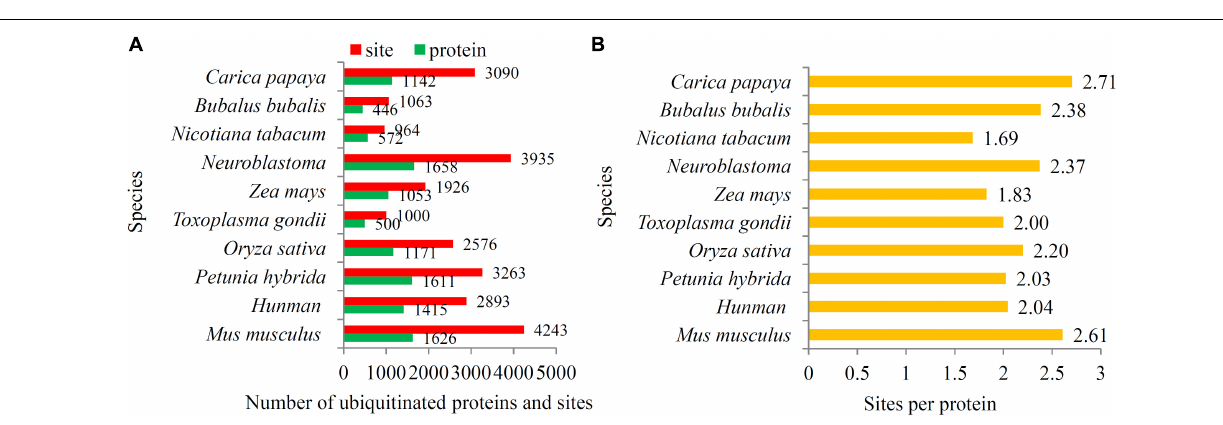
FIGURE 3 | Analysis of the differences between papaya and other published organisms. (A) The number of ubiquitinated proteins and ubiquitination sites in papaya and other published organisms. Red bars indicated the number of ubiquitinated proteins and green bars indicated the number of ubiquitinated sites. (B) The number of ubiquitination sites per protein in papaya and other published organisms, including Bubalus bubalis, Nicotiana tabacum, Neuroblastoma, Zea mays, Toxoplasma gondii, Oryza sativa, Petunia hybrida, Human, and Mus